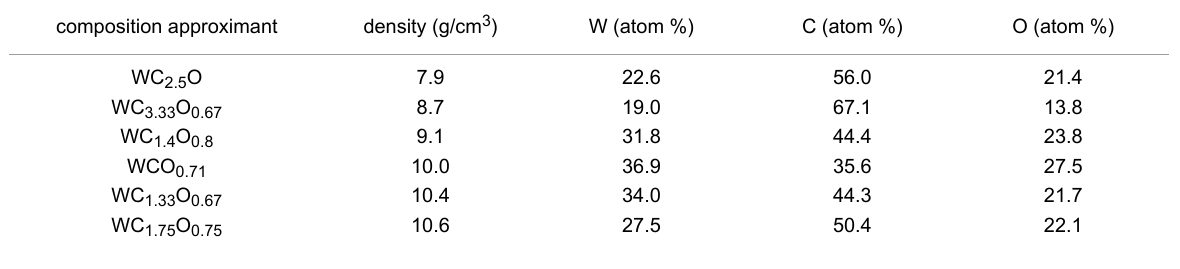
Table 1: Composition of the six amorphous tungsten oxycarbide deposits considered in this study, following [16] and given in terms of atomic percent (atom %). They are sorted by increasing density, which was determined in [23] (see text). composition approximant